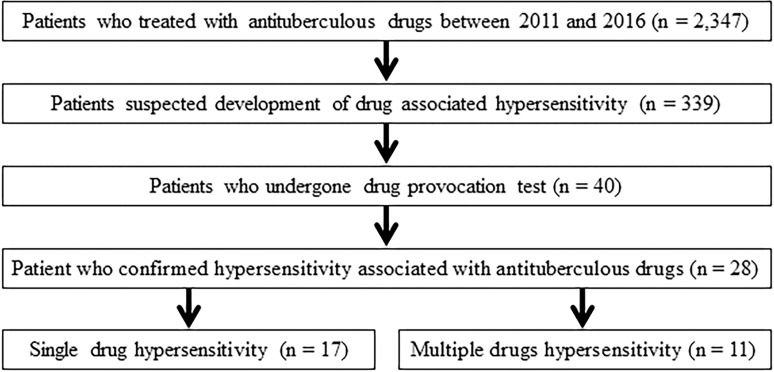
Study flowchart.